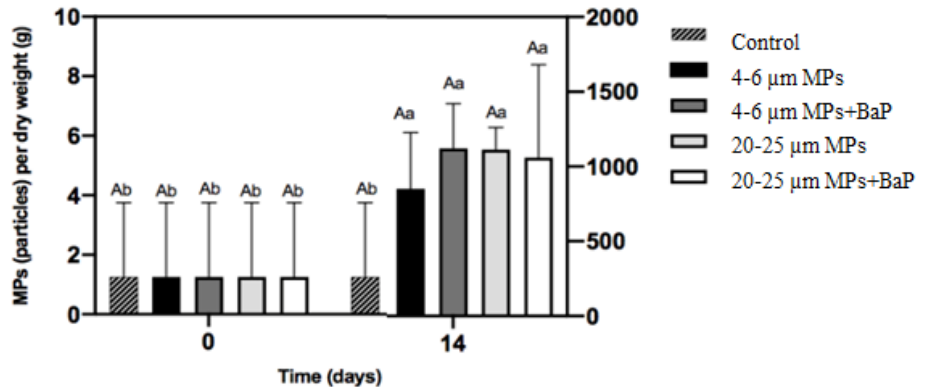
Figure 1. MPs accumulation per gram of dry weight (mean ± SD) of the soft tissues of S. plana after 14 days of exposure. Different capital letters indicate a significant difference between treatments within the same time. Different lowercase letters indicate a significant difference for the same treatment between times ( p < 0.05).